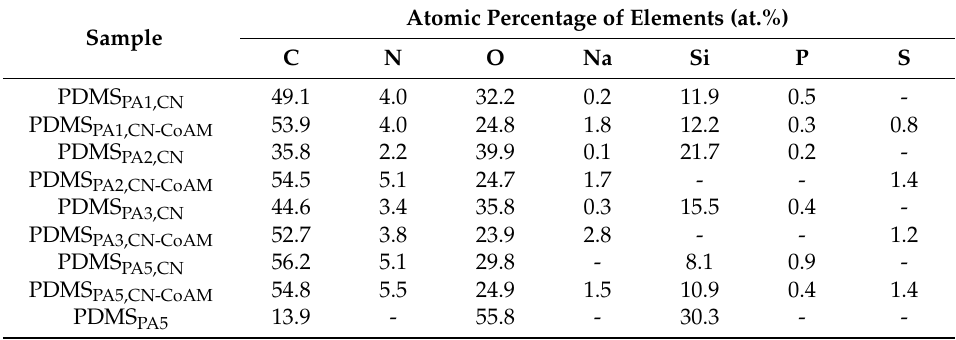
Table 4. Elemental analysis of the plasma-activated silicone surfaces (1 min, 2 min, 3 min and 5 min) coated by chitosan nanoparticles alone, or in combination with the drug by XPS. Atomic Percentage of Elements (at.%) Sample Na PDMS PA1,CN PDMS PA1,CN-CoAM PDMS